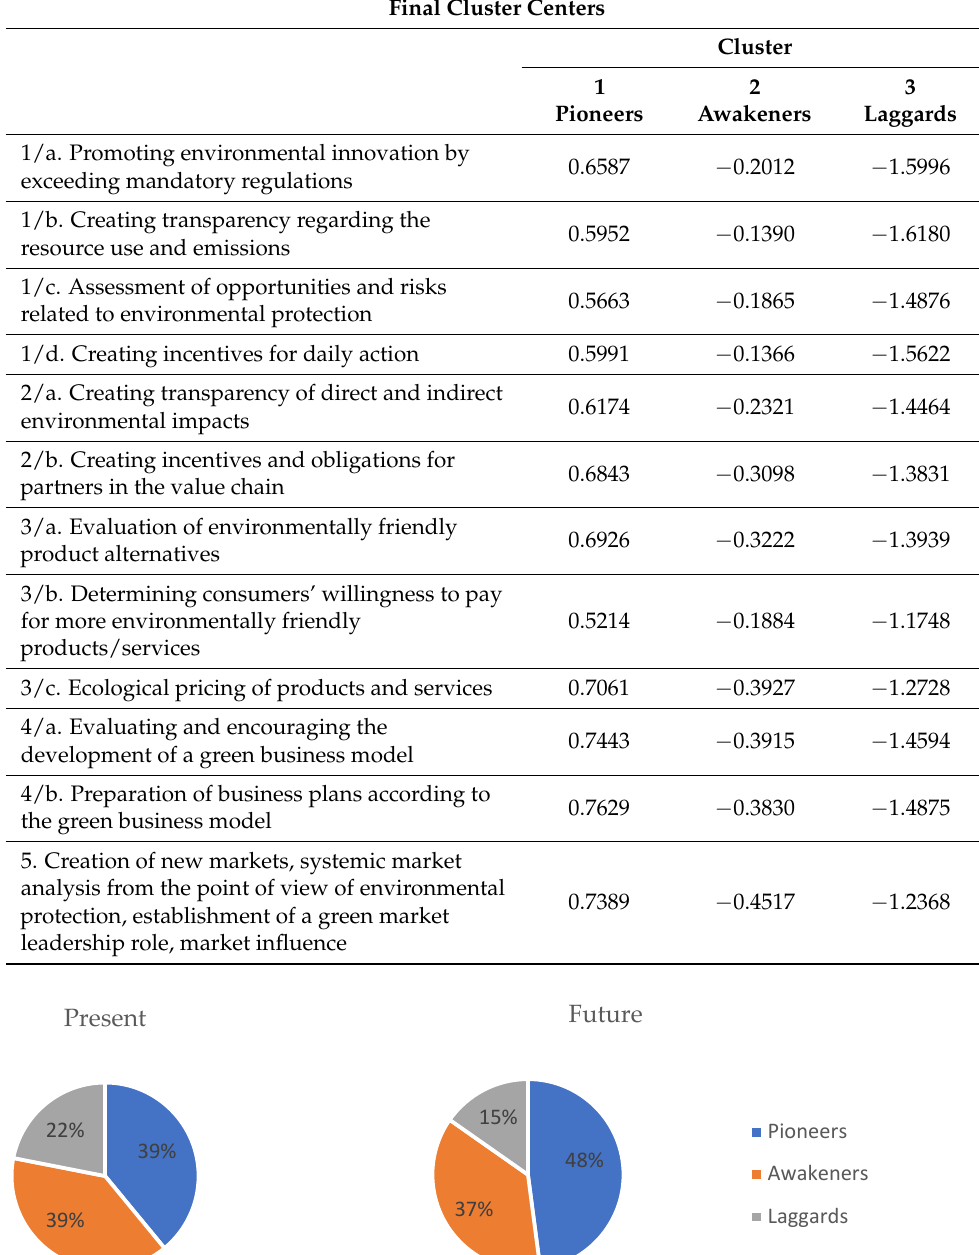
Table 8. The cluster centers in the examined sample for the future. Source: edited by authors.